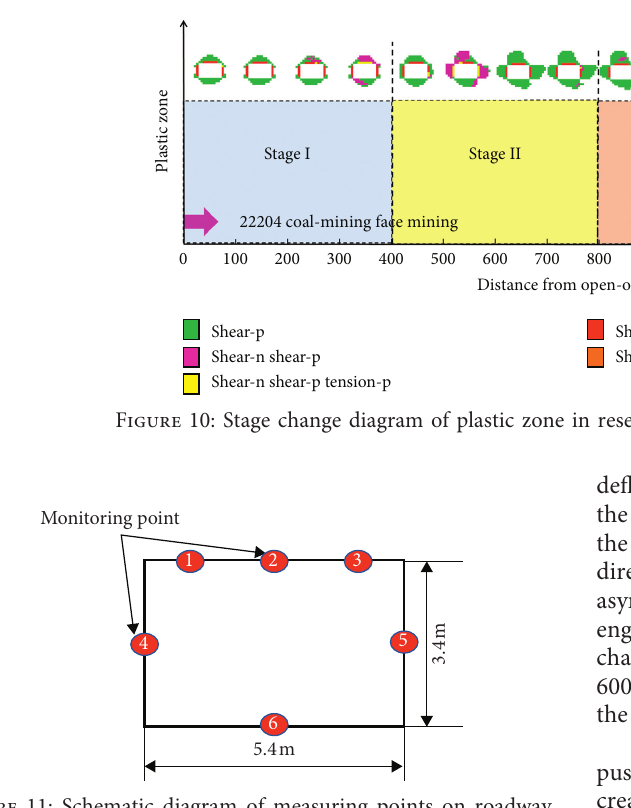
Figure 11: Schematic diagram of measuring points on roadway